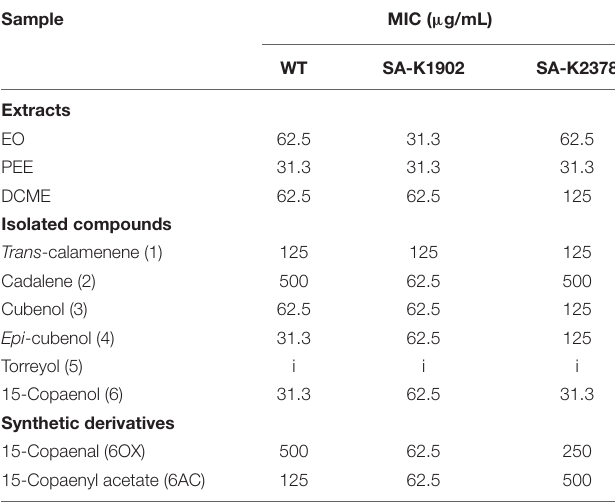
TABLE 2 | MICs of essential oils (EOs), petroleum ether extracts (PEEs), dichloromethane extract (DCME), isolated sesquiterpenes, and synthetic derivates from P. uviferum on S. aureus